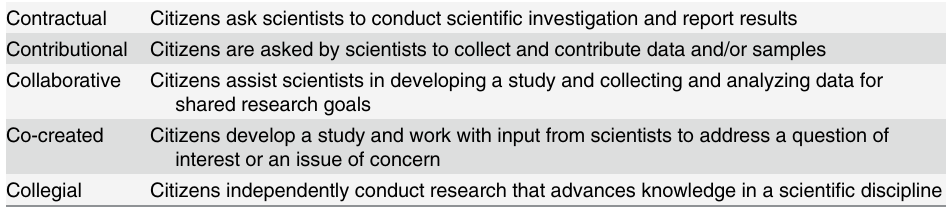
Table 3. Five engagement modes describing possible relationships between scientists and citizen scientists in the development and implementation of citizen science studies, sensu Shirk et al.